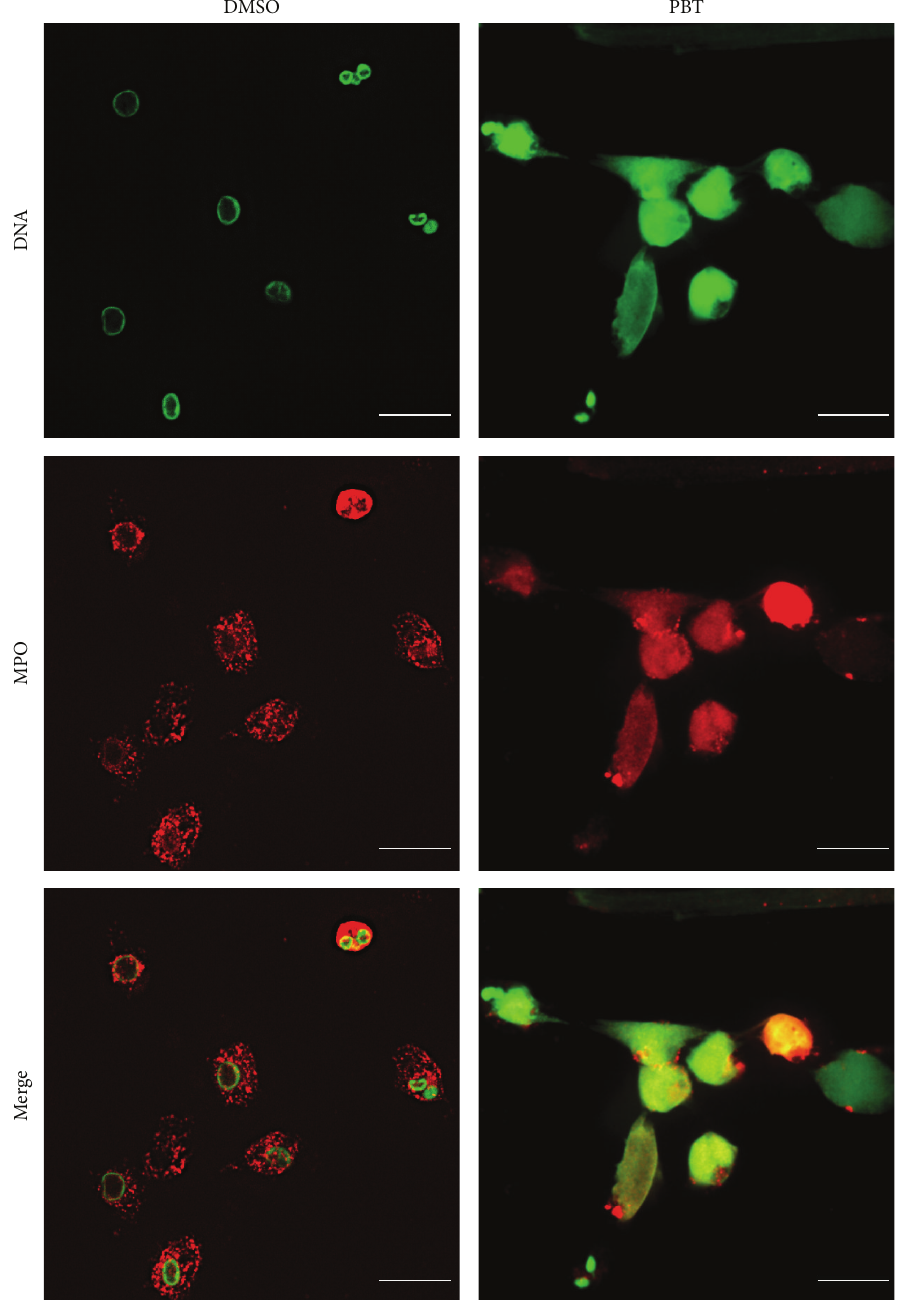
Figure 4: PBT-3 induces NETosis. Fourhours after stimulation with either vehicle or PBT-3 (20 𝜇 g/mL), cells were fixed and stained for immunofluorescence analysis. Cells were stained for DNA (green) and MPO (red) after activation with PBT-3 (20 𝜇 g/mL). Images are representative of 3 independent